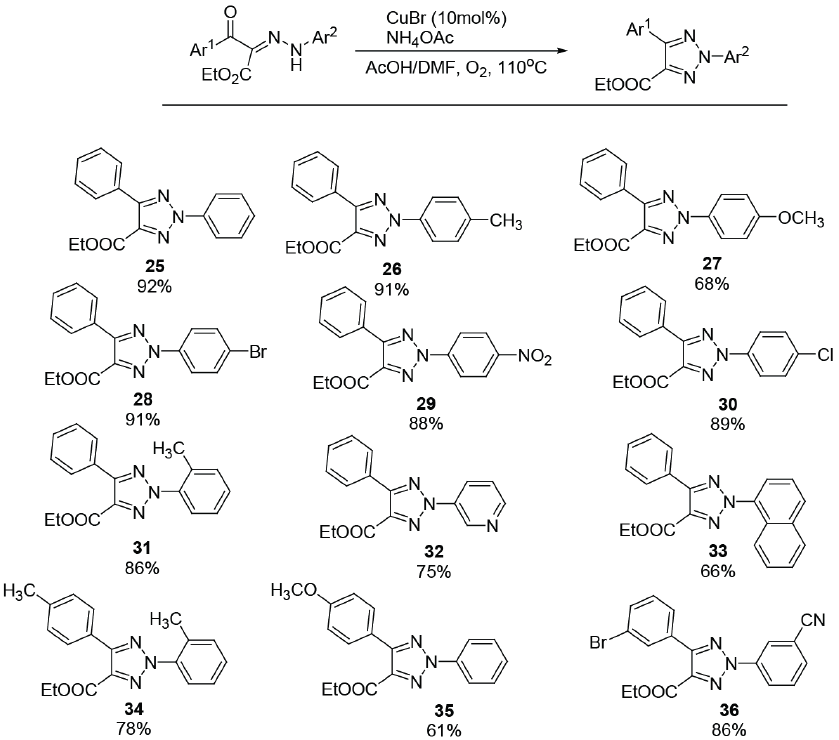
Figure 8 - Intramolecular copper catalyzed cyclization of β-ketohydrazones for the synthesis of N2-Aryl-1,2,3-Triazoles